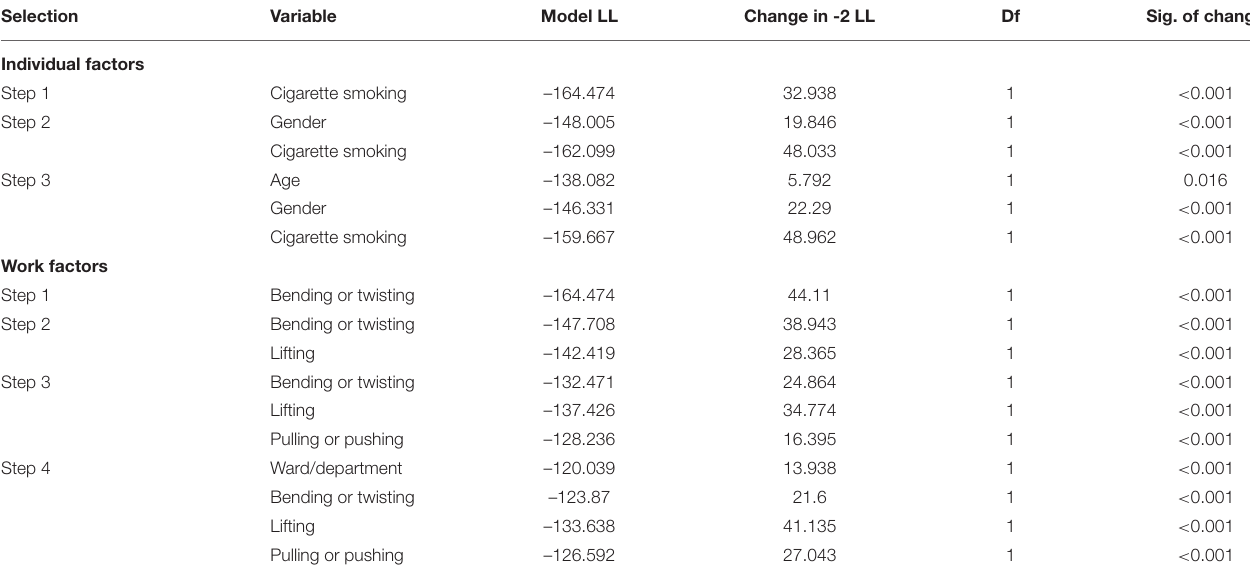
TABLE 4 | Forward stepwise regression analysis of factors associated with